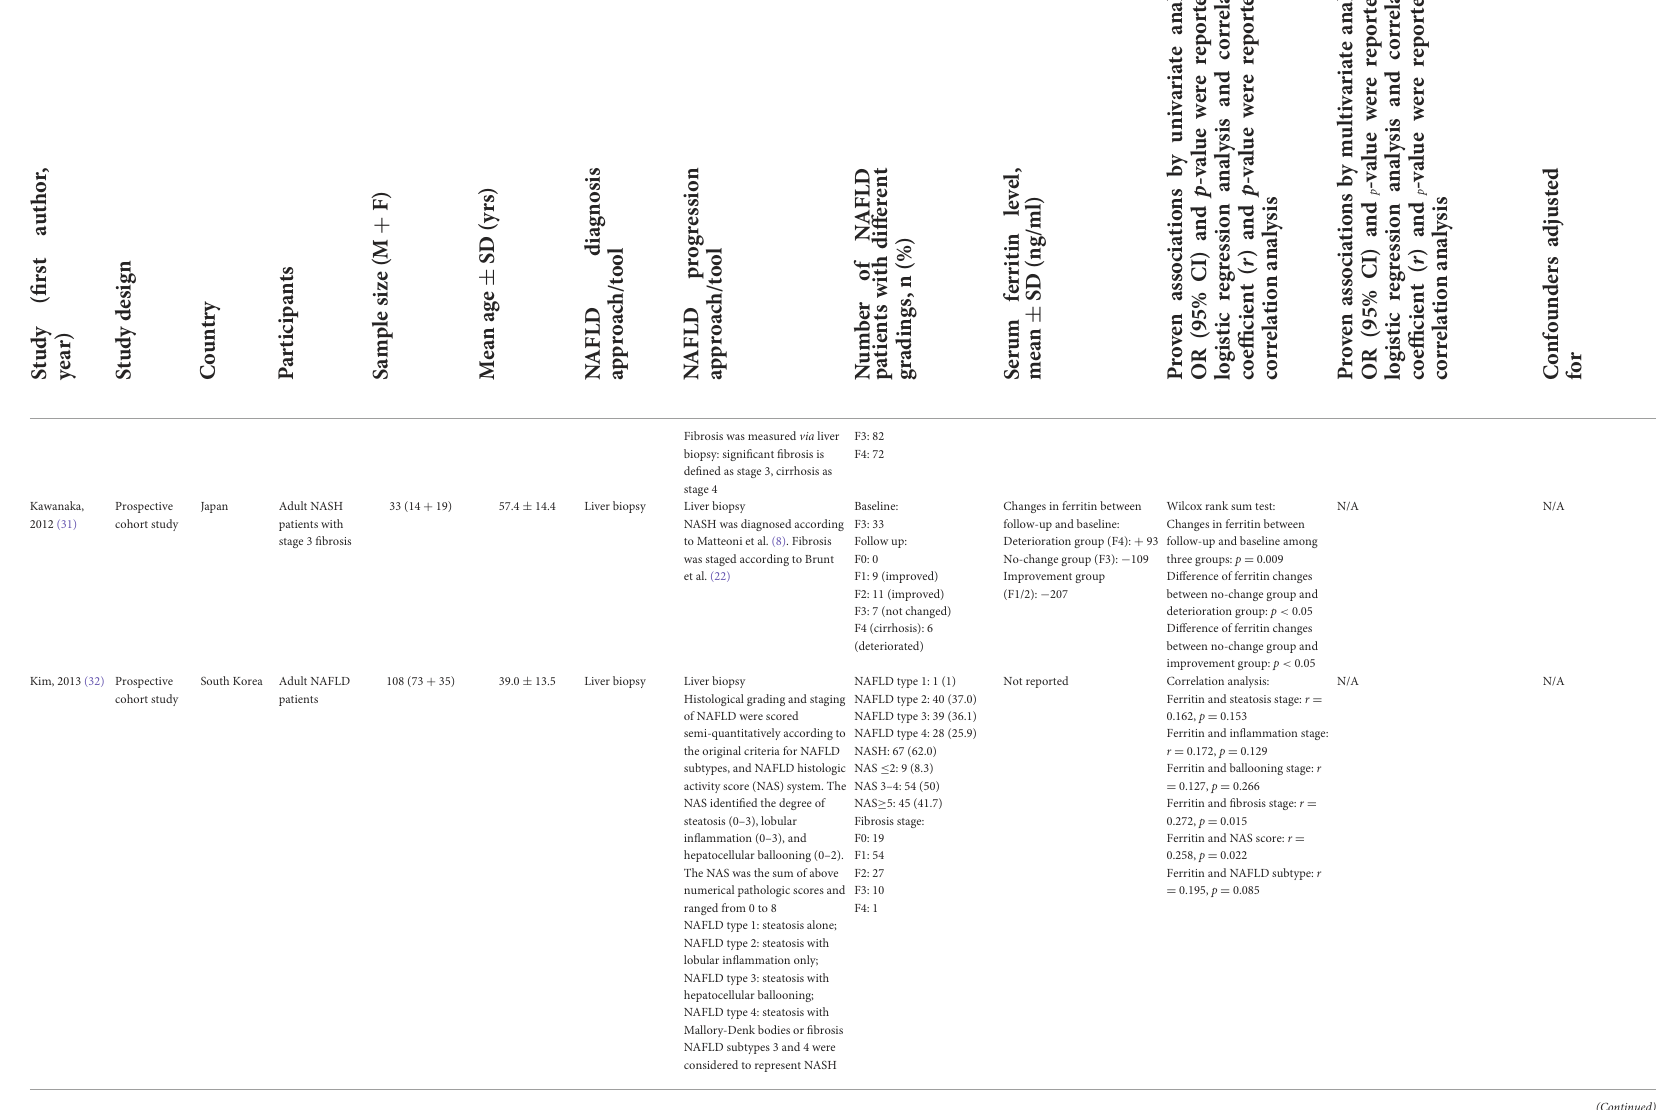
ofNAFLDwerescored semi-quantitativelyaccordingto theoriginalcriteriaforNAFLD subtypes,andNAFLDhistologic activityscore(NAS)system.The NASidentifiedthedegreeof steatosis(0–3),lobular inflammation(0–3),and hepatocellularballooning(0–2). TheNASwasthesumofabove numericalpathologicscoresand rangedfrom0to8 NAFLDtype1:steatosisalone; NAFLDtype2:steatosiswith lobularinflammationonly; NAFLDtype3:steatosiswith hepatocellularballooning; NAFLDtype4:steatosiswith Mallory-Denkbodiesorfibrosis NAFLDsubtypes3and4were consideredtorepresentNASH